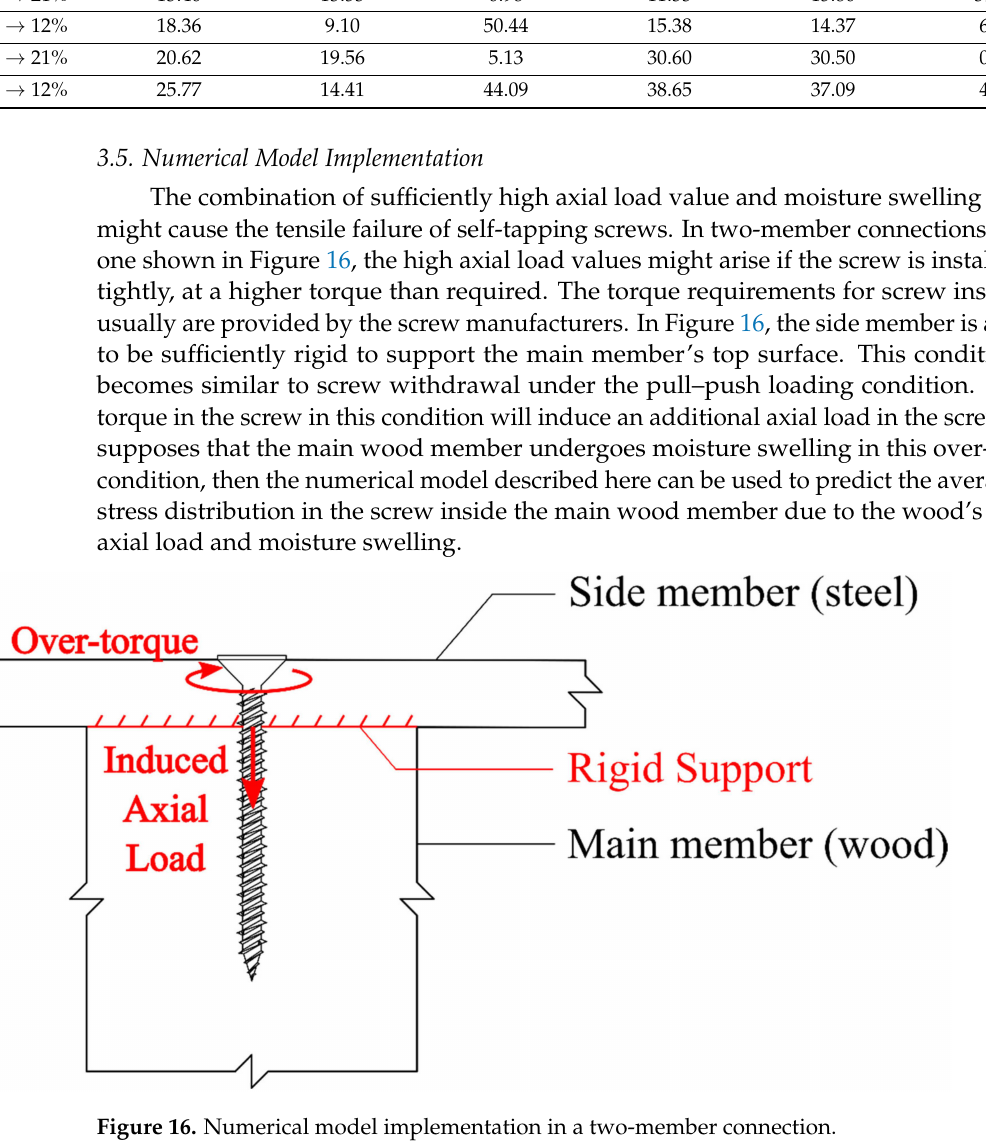
Figure 16. Numerical model implementation in a two-member